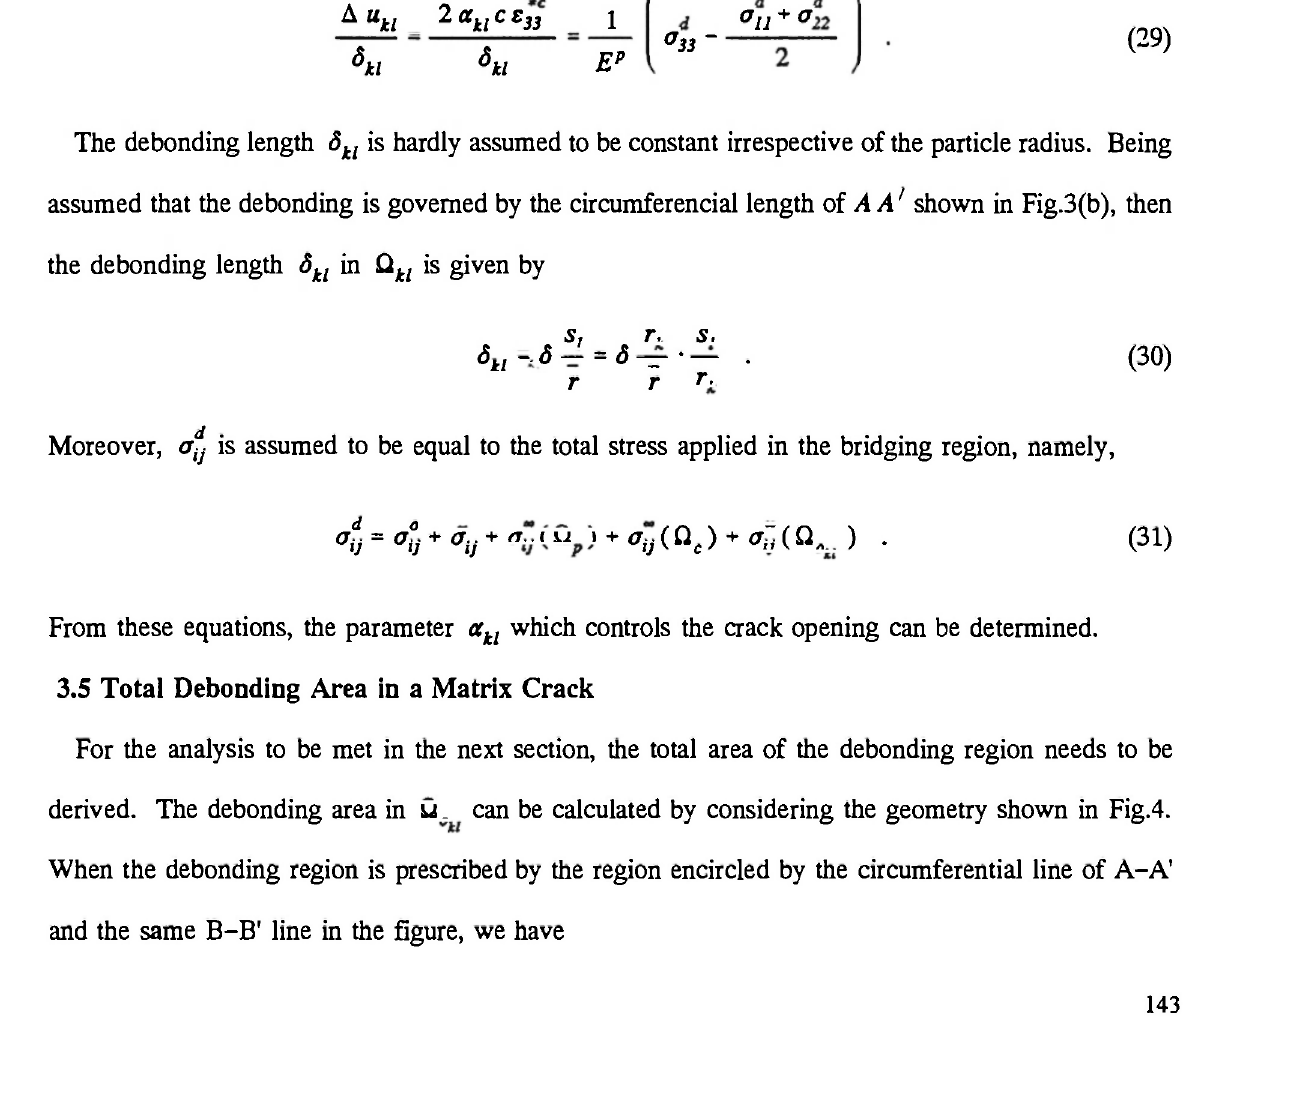
Fig.3 Modeling of interfacial debonding. (a) Interfacial phenomena.